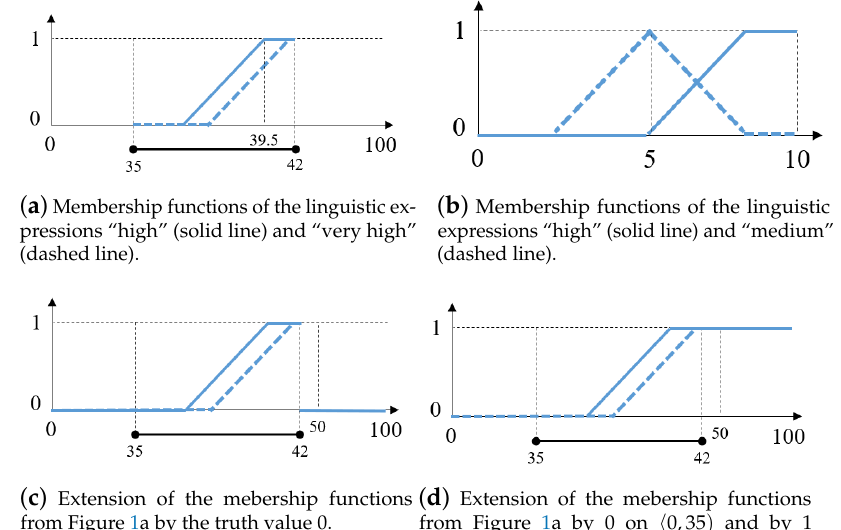
Figure 1. An illustration of membership function extensions to a wider domain using specially chosen degrees of